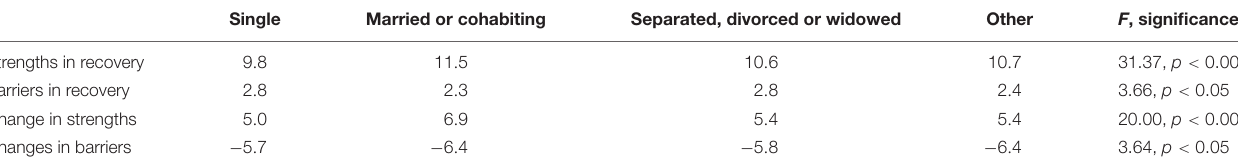
TABLE 4 | Mean number of strengths and barriers while in recovery and changes in strengths and barriers from addiction to recovery, by relationship status ( n = 1,313). Single Married or cohabiting Separated, divorced or widowed